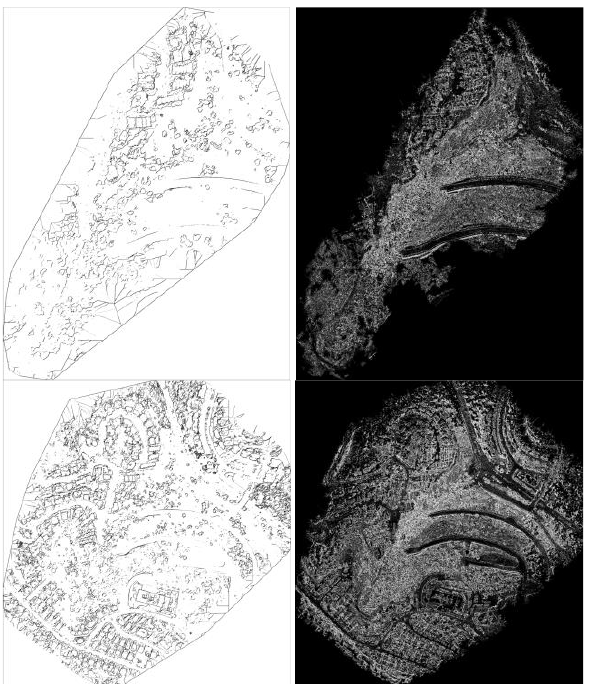
Figure 9. Burning temperatures map reconstructed from the RGB images collected by UAV